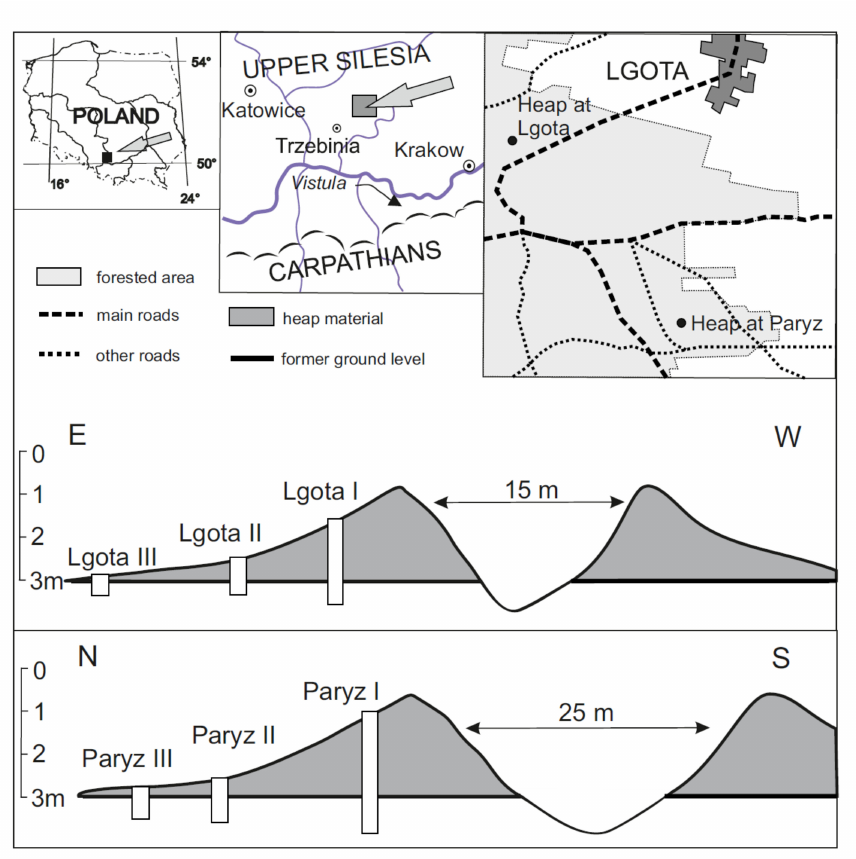
Figure 1. The research region and sampling locations (according to